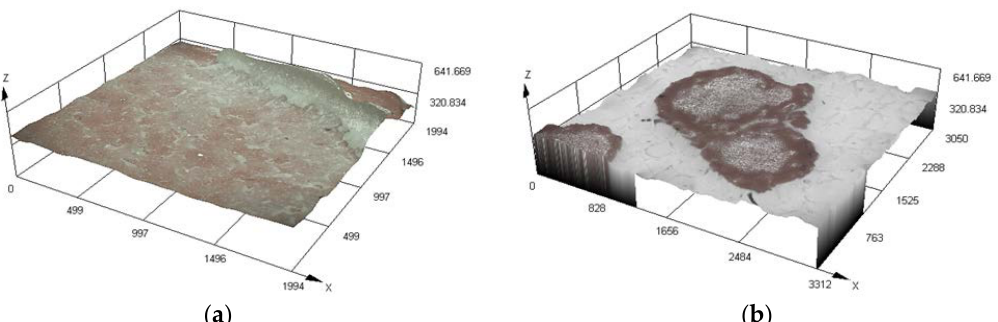
Figure 10. Detail of pull-off failures of treated ABS–PU and treated ABS–EP. ( a ) APS + APPT/PU; ( b ) APS + APPT/EP.